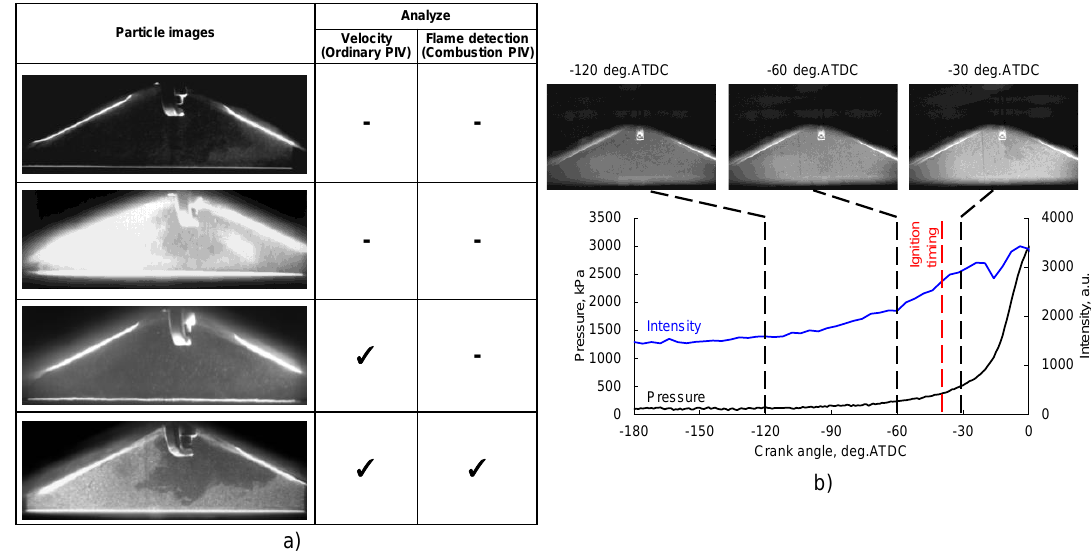
Figure 4. ( a ) The effects of difference seeds amount on the clarity and feasibility of the information that can be measured, ( b ) variation of PIV intensity from BDC to TDC of a firing cycle.